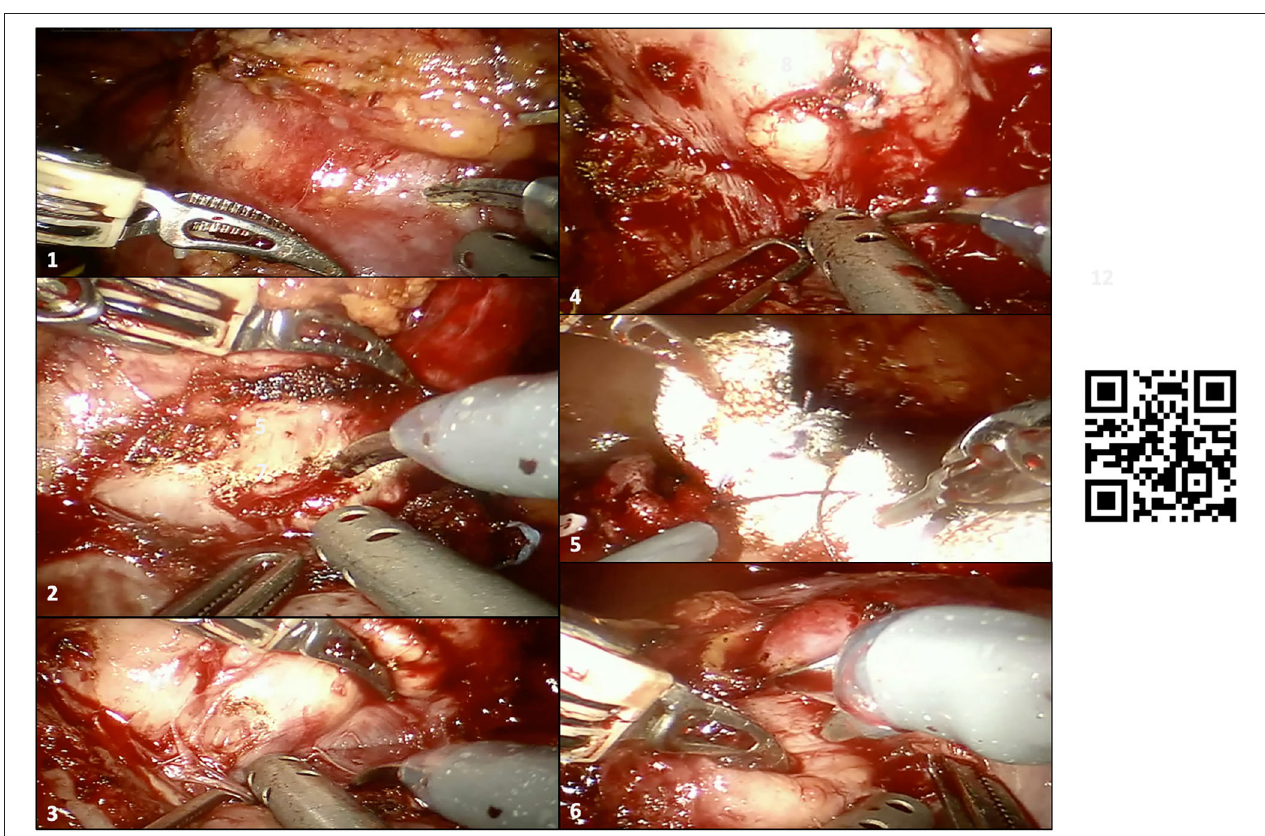
FIGURE 4 | Intraoperative snapshot showing the main steps of robot-assisted partial nephrectomy (RAPN) in our case. (1–4) Development of the enucleation plane for resection of the larger renal mass (before clamping the renal hilum), with inadvertent capsulotomy of the tumor during tumor enucleation after clamping of the renal hilum (2); the surgeons recognized the wrong plane of dissection and continued the enucleation through the real anatomic plane between the tumor and the healthy renal parenchyma with no macroscopic positive margins; (5) double-layer renorrhaphy to close the renal defect after tumor enucleation of the larger renal mass; (6) enucleation of the smaller hilar renal mass, which was in contact with both vascular structures and the sinus fat. A linked video clip is available scanning the QR code on the right side of the image. For Apple users: open the Camera app from your devices. Hold your device so that the QR code appears in the Camera app’s viewfinder. Your device recognizes the QR code and shows a notification. Tap the notification to open the link associated with the QR code. For Android users: download a QR code scanner app and follow the above